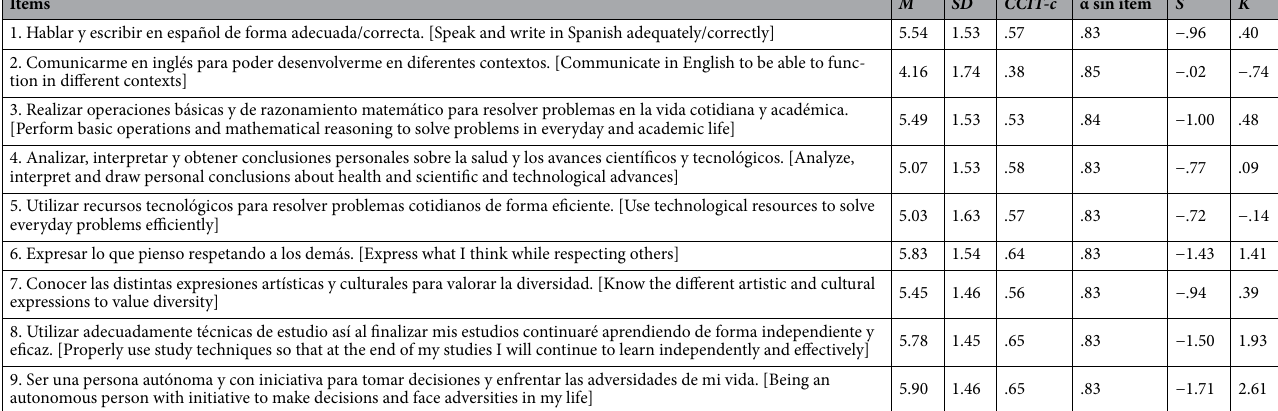
Table 1. Descriptive statistics, internal consistency and homogeneity (n = 748). N, sample; M, mean; SD, standard deviation; CCIT-c, corrected coefficient of item-total correlation; S, skewness; K, kurtosis.